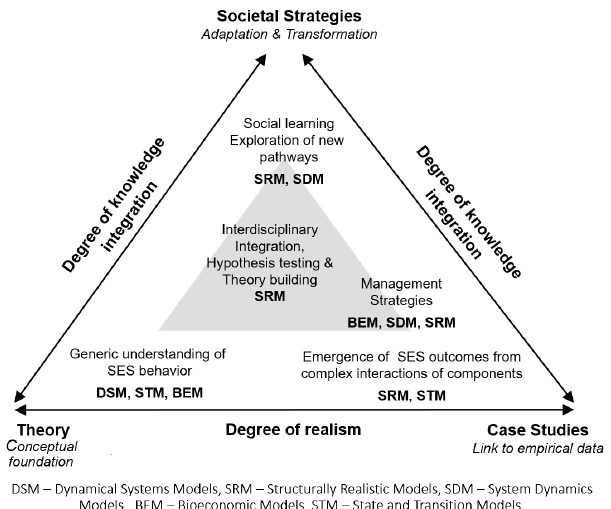
Fig. 1. The reference frame “modeling for social-ecological systems research” (ModSES). The gray area indicates the location of stylized or toy models, which can be built using different model types. SES = social-ecological system.